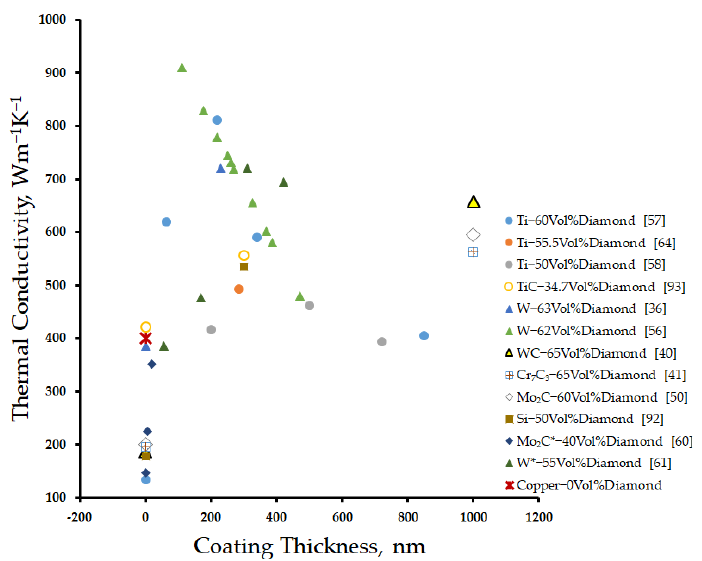
Figure 4. Effect of the carbide coating thickness on the diamond surface on the thermal conductivity of copper matrix composites.